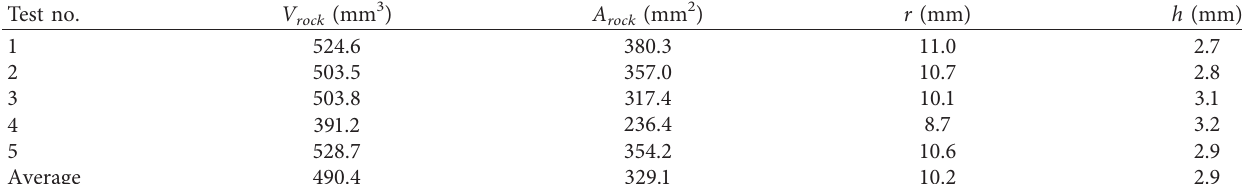
Table 4: Results of button impact tests.